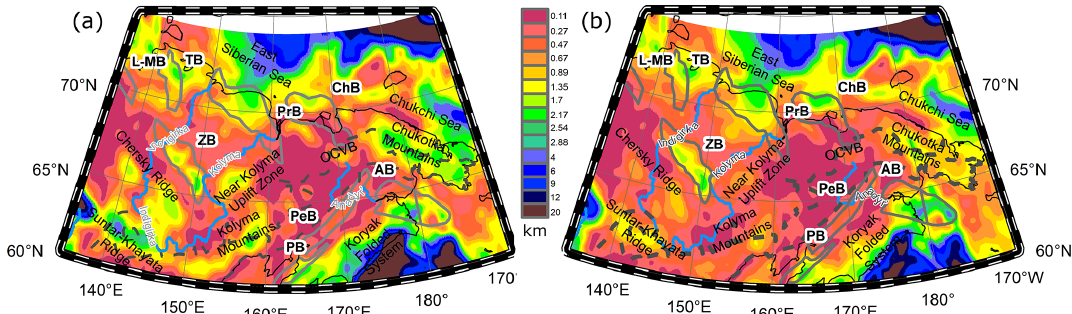
Figure 8. New model of sedimentary cover. (a) Model 1. (b) Model